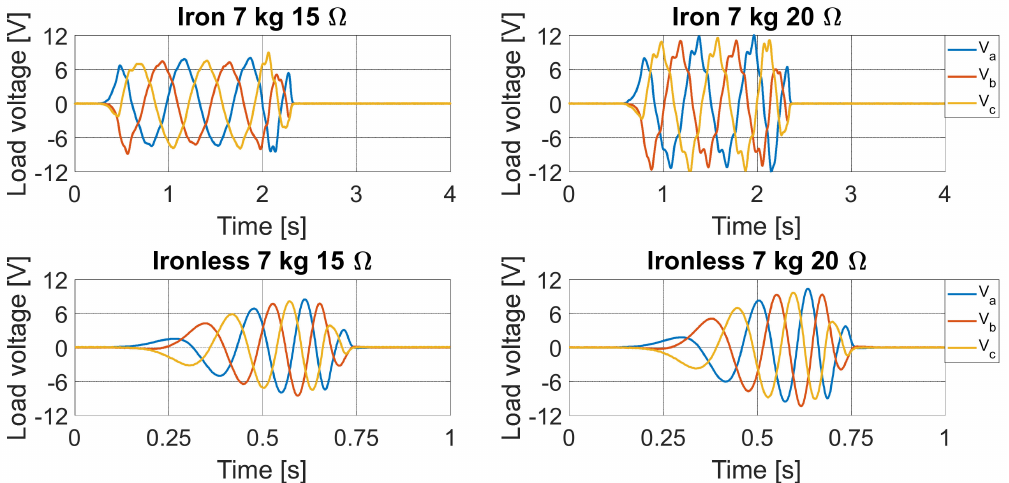
Figure 17. Load voltages trends of the 7 kg test with a resistance load equal to 15 Ω and 20 Ω .